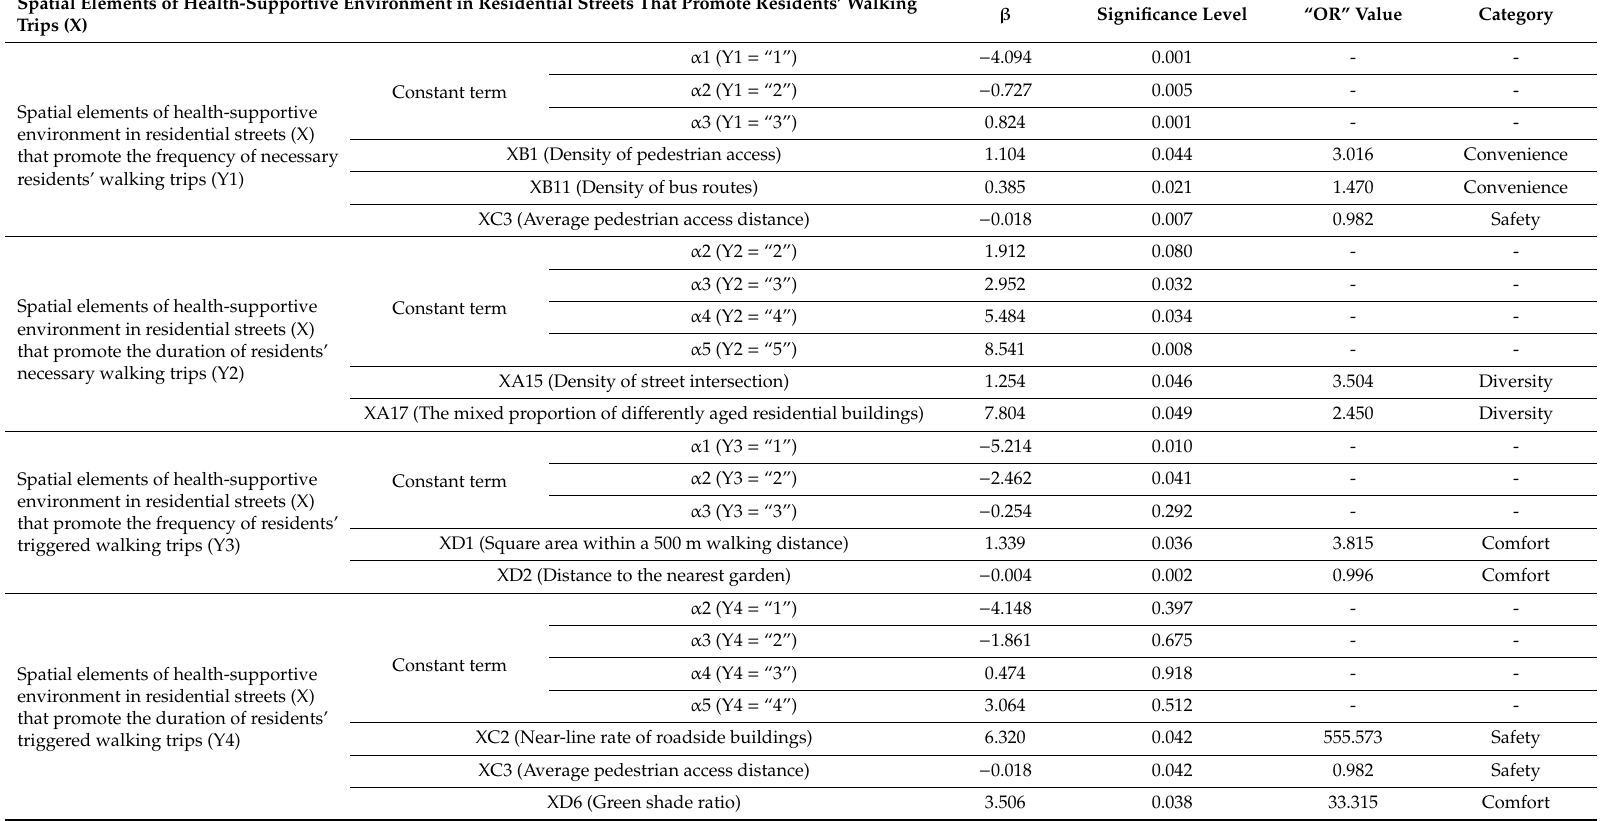
Table 7. Ordered logistic regression analysis 1